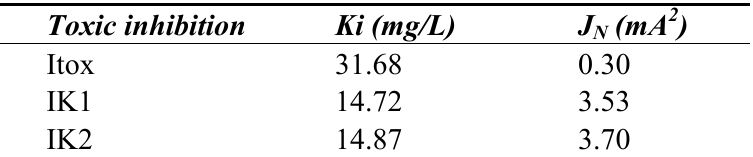
Table 1. Fitting of the polarization curve for 20 mg/L Ni to the extended Butler Volmer Monod (BVM) models (Equations (1)–(3)).